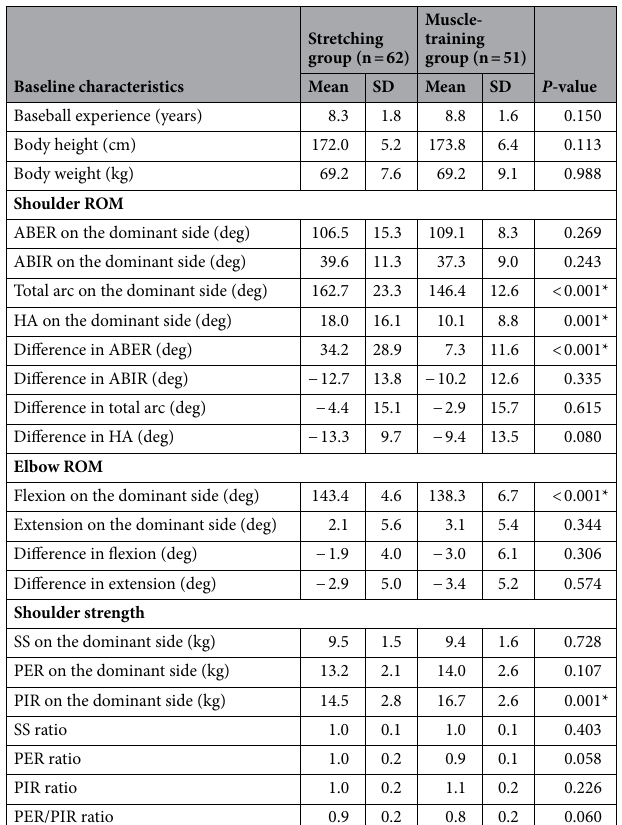
Table 1. Baseline characteristics. * P < 0.05. Total arc = ABER + ABIR. Difference = ROM on the dominant side—ROM on the non-dominant side. Strength ratio = strength of the dominant/non-dominant side. PER/PIR ratio = PER/PIR of the dominant side. ABER and ABIR, ROM in 90° shoulder abduction external and internal rotation, respectively; HA, horizontal adduction; PER, prone external rotation; PIR, prone internal rotation; ROM, range of motion; SD, standard deviation; SS, supraspinatus in the seated position.